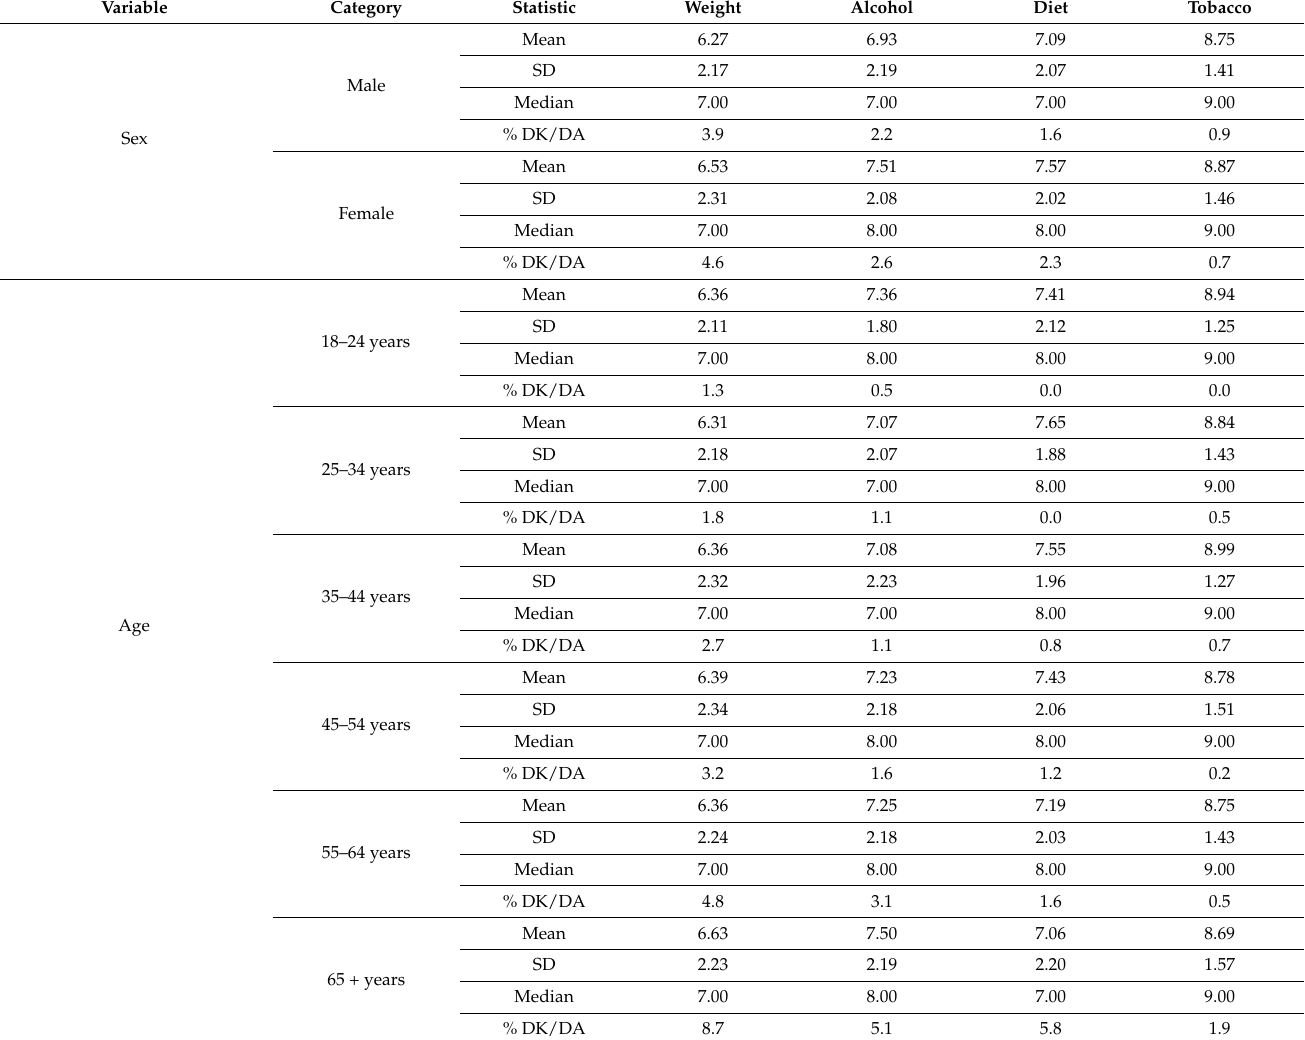
Table A1. Influence ratings (1 to 10 scale) and percentage DK/DA responses (“Does not know” or “Does not answer”) within each variable category for the four lifestyle factors. Note: “Does not answer” was rare, between 0.1% and